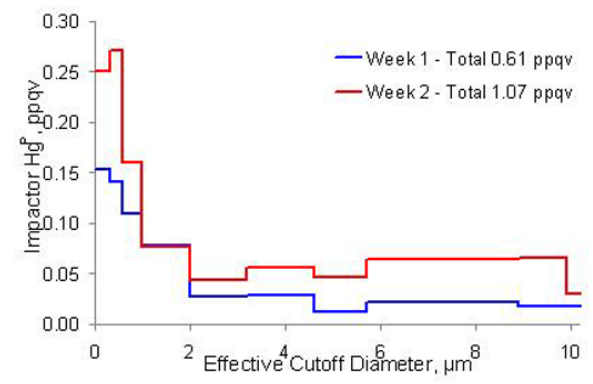
Fig. 3. Diurnal Distribution of Hg P at Appledore Island in summer 2009. There is more than twice as much Hg P during the day, due to many variables including enhanced sea salt generation and more RGM production during sunny days.